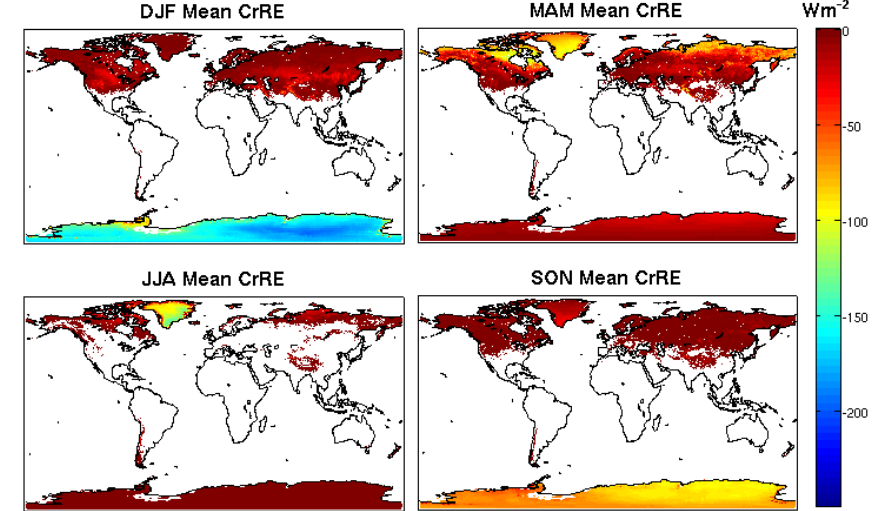
Figure 4. Tri-monthly seasonally averaged LCrRE derived with the CAM4 all-sky kernel (DJF – December, January, February; MAM –